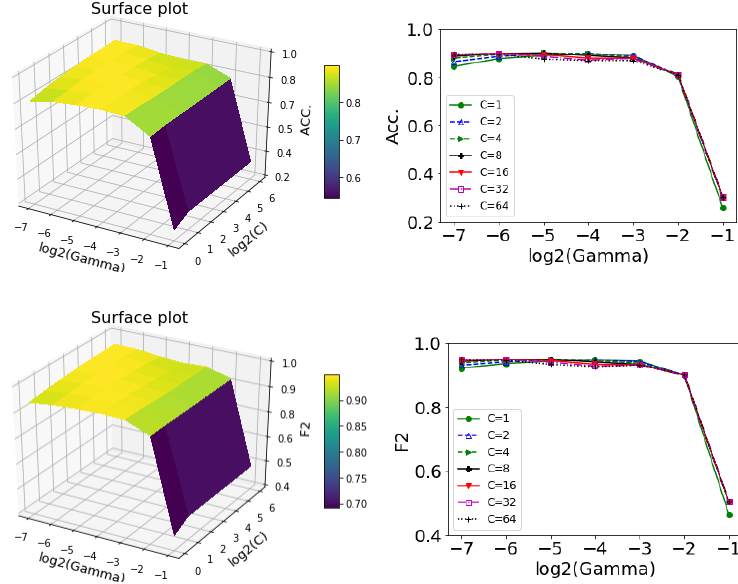
Figure 8. Effect of parameters on support vector classification performance.